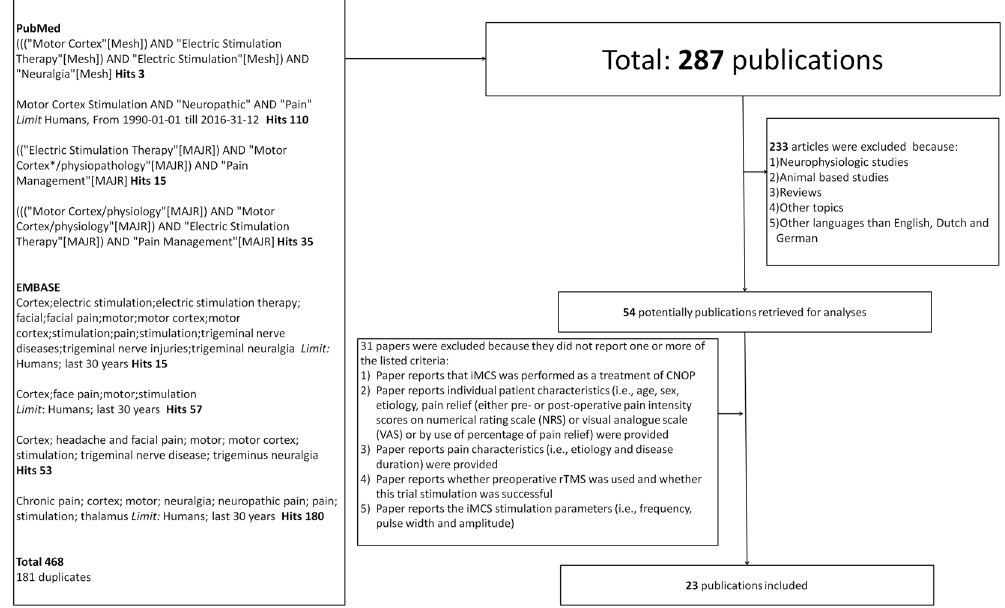
Figure 1. Flow-diagram of the study-selection process. CNOP: Chronic neuropathic orofacial